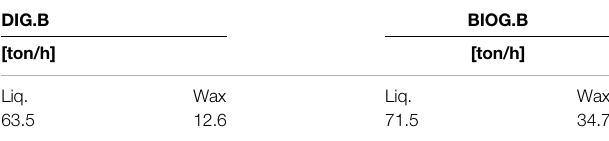
TABLE 4 | Production of FT compounds utilizing biomethane plants ’ CO 2 and digestate fl ows.